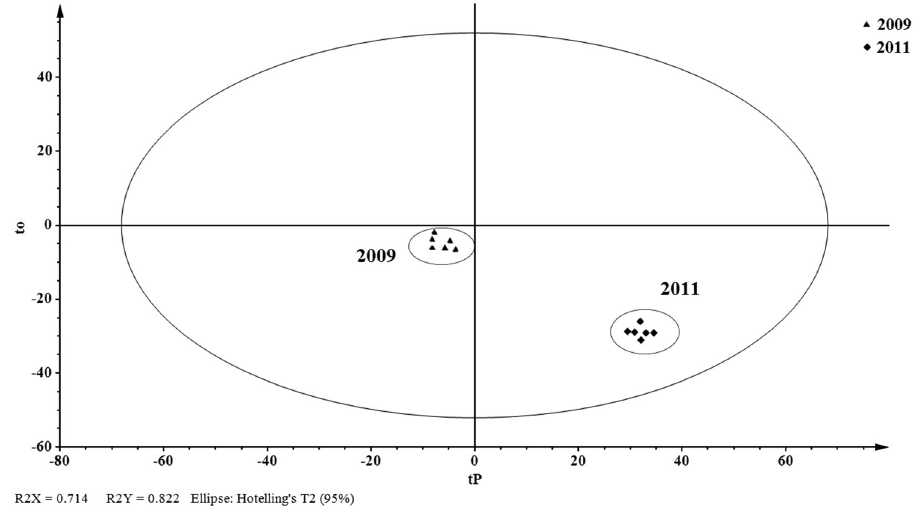
Figure 7: OPLS - DA score plot chart from 1 H NMR spectra of 2009 and 2011 vintage Cabernet Sauvignon wines.